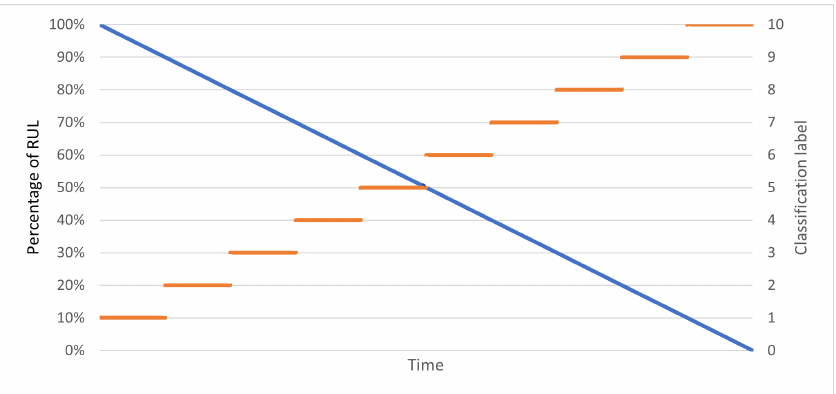
Figure 8. RUL and Classification